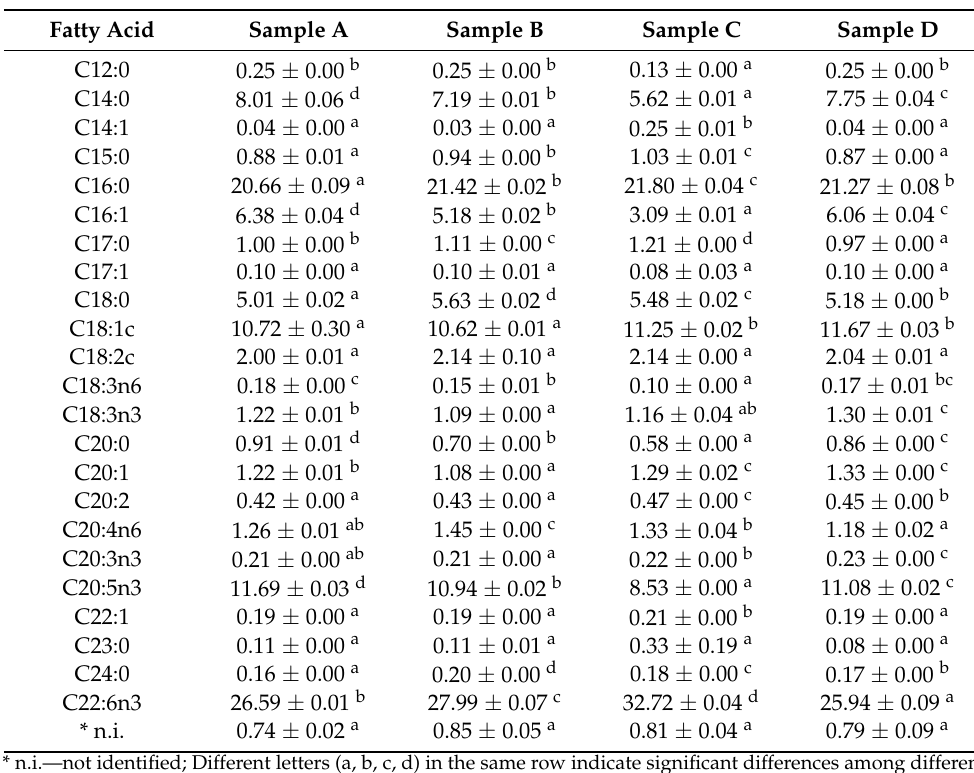
Table 4. Fatty acid composition of samples A and B were handled by the traditional method, and samples C and D were handled by the modified handling method. Results expressed as % of total fatty acids.